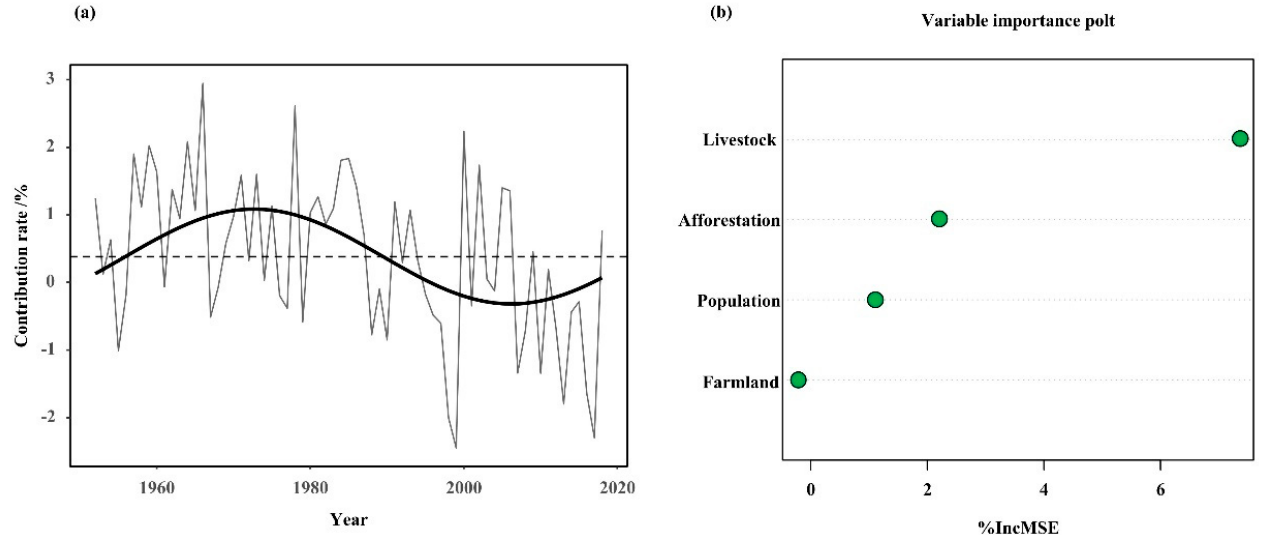
Figure 9. Contribution of human activities to dynamic changes in vegetation greenness dynamics ( a ). Ranking of the importance of factors influencing changes in vegetation greenness dynamics ( b ). The X-axis of Figure 9a is time, and the Y-axis is the contribution of human activities to the NDVI in the study area; the X-axis of Figure 9b is “%IncMSE”, which means the increase in the mean squared error, and the Y-axis is the importance of various types of human activities.